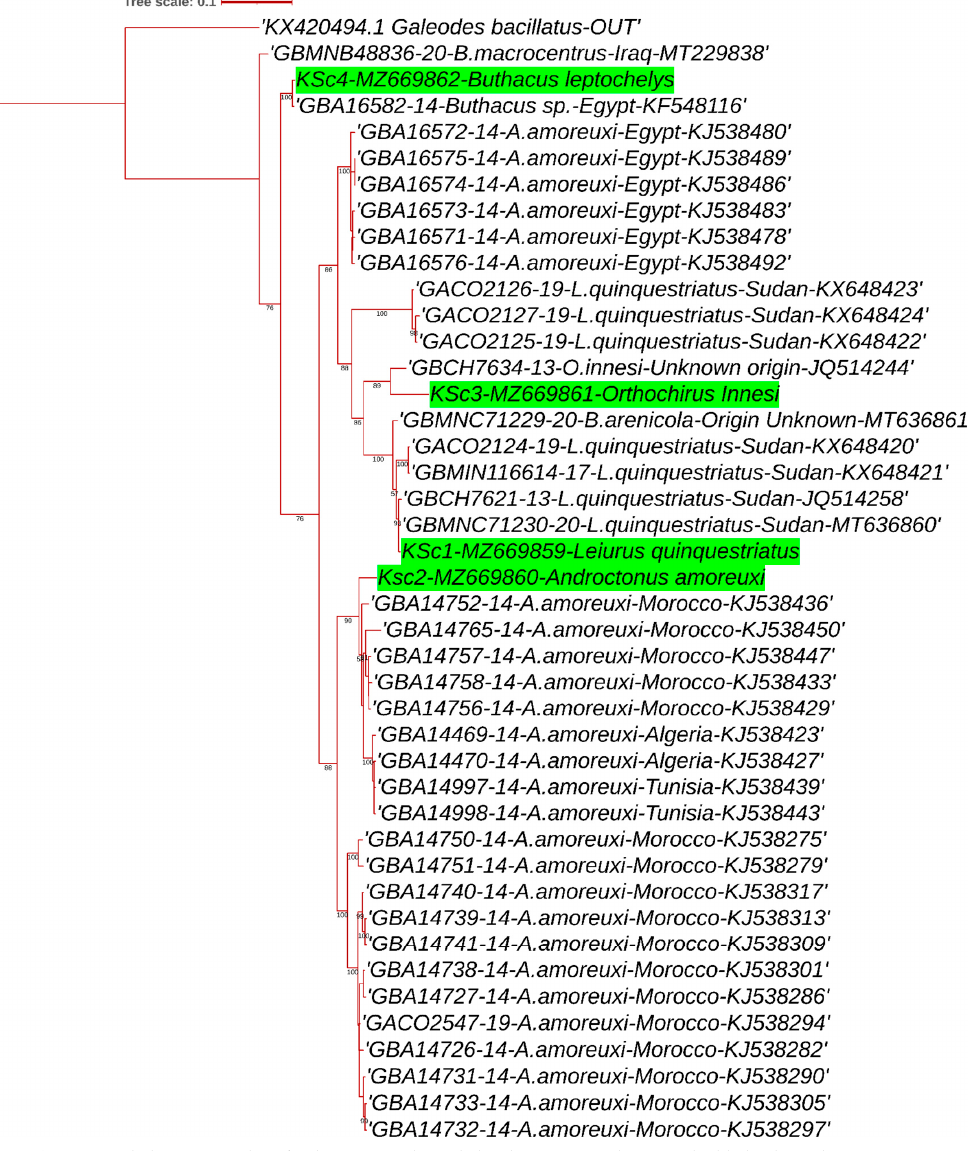
Figure 5. BI phylogenetic analysis for the scorpions barcoded in the current study (Green-highlighted) in relation to BOLD and GenBank references. Four Markov chain Monte Carlo (MCMC) chains were analyzed for ten million (ngen = 10,000,000) generations. Bootstrap values are shown above the branches. References´ labels are ordered as BOLD BIN-Genus, species-Origin-GenBank accession number. The sequence of COI barcode of the spider Galeodes bacillatus was used as an outgroup.